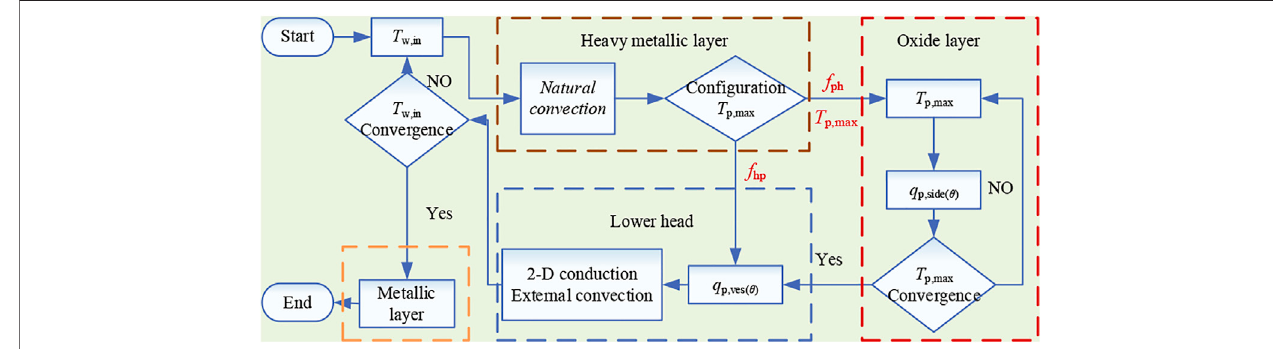
FIGURE 8 | Flow chart of the coupled analysis method in MPCAP code.